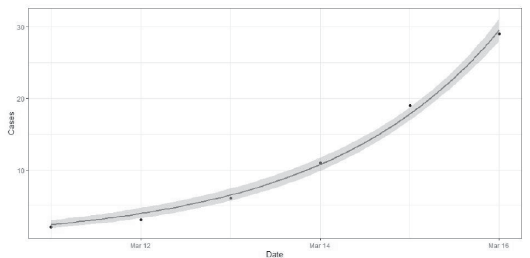
Figure 2: Total cases in Sri Lanka from 11 March to